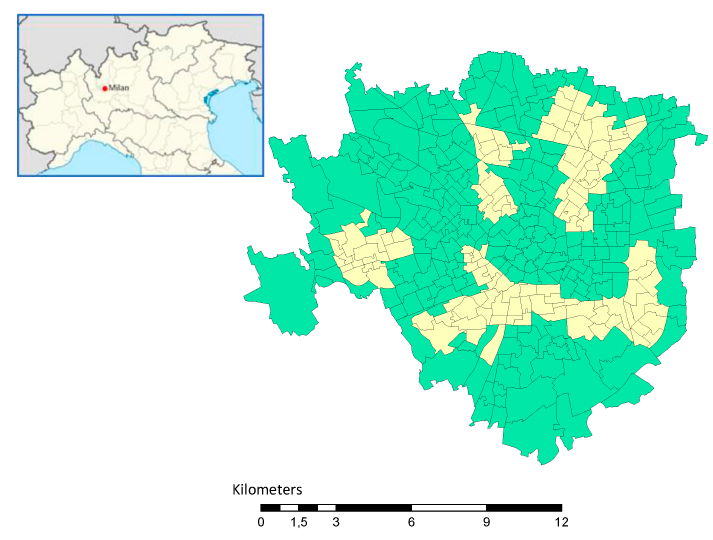
Figure 1. Map of Milan with the traffic origin zones (green) taken into account to evaluate average trip length.